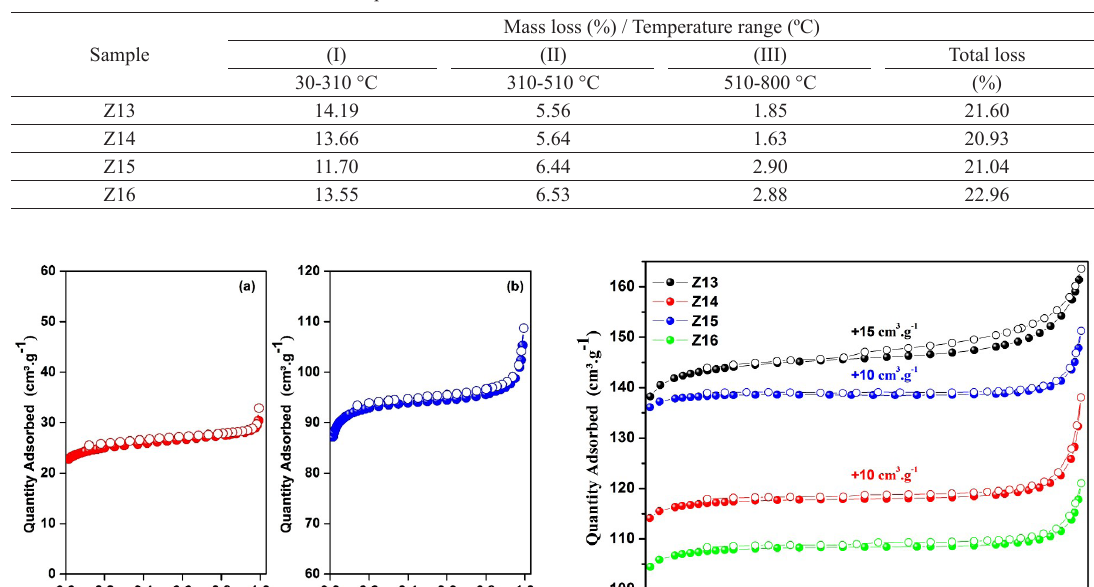
Figure 2. Mass loss profiles from thermal analysis (TG/DTG) of the SSZ-13 samples. Table 2. Mass loss of the zeolite SSZ-13 samples.